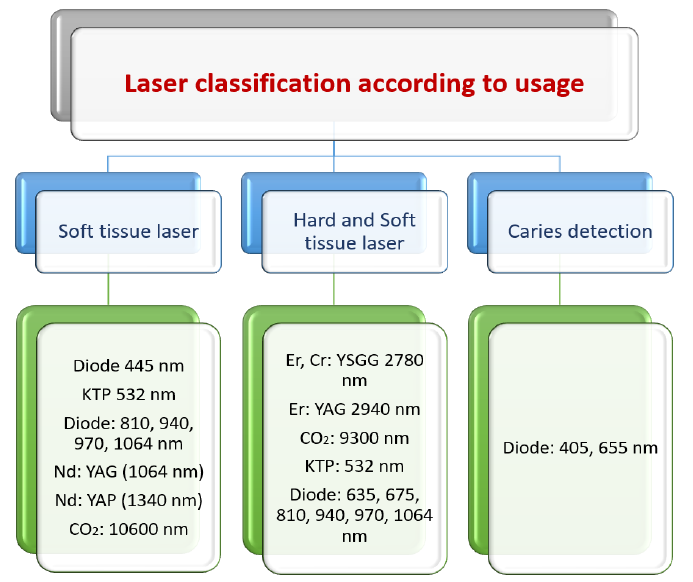
Figure 2. Classification of laser according to its usage and wavelength.